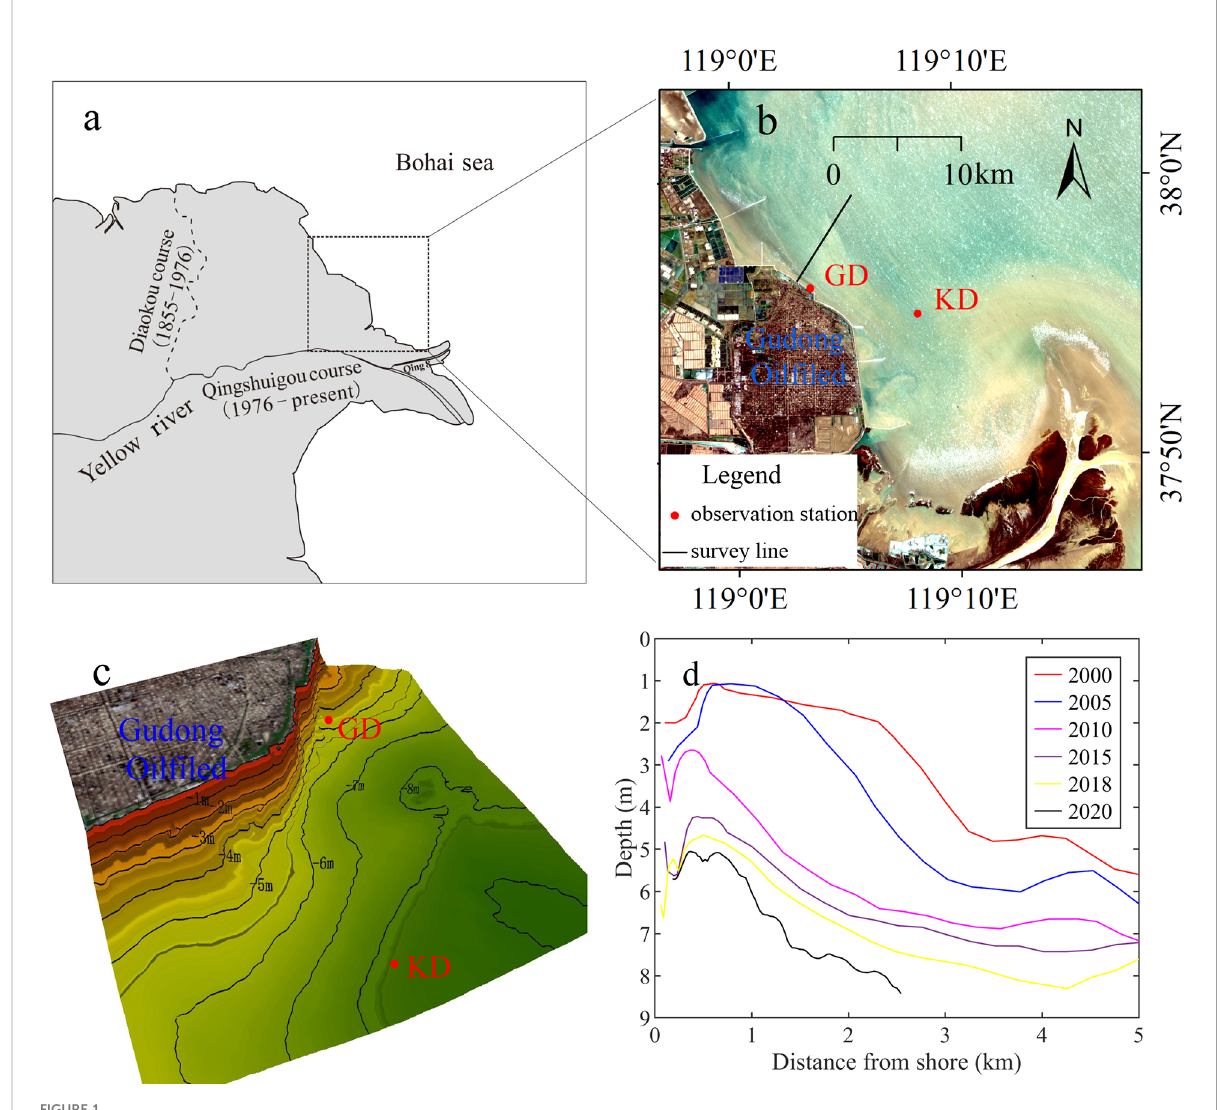
FIGURE 1 Overview of the study area; (A) Location of the Gudong seawall; (B) Remote sensing image of the Gudong Oil fi eld from lansat satellite (URI: https://landsat.gsfc.nasa.gov/); black line indicates bathymetric survey line. (C) Topographic map based on water depth data in 2018. (D) Water depth pro fi les of the bathymetric line in ‘ b ’ . Red spots marked with GD and KD in (B) and (C) indicate locations of the observation stations.